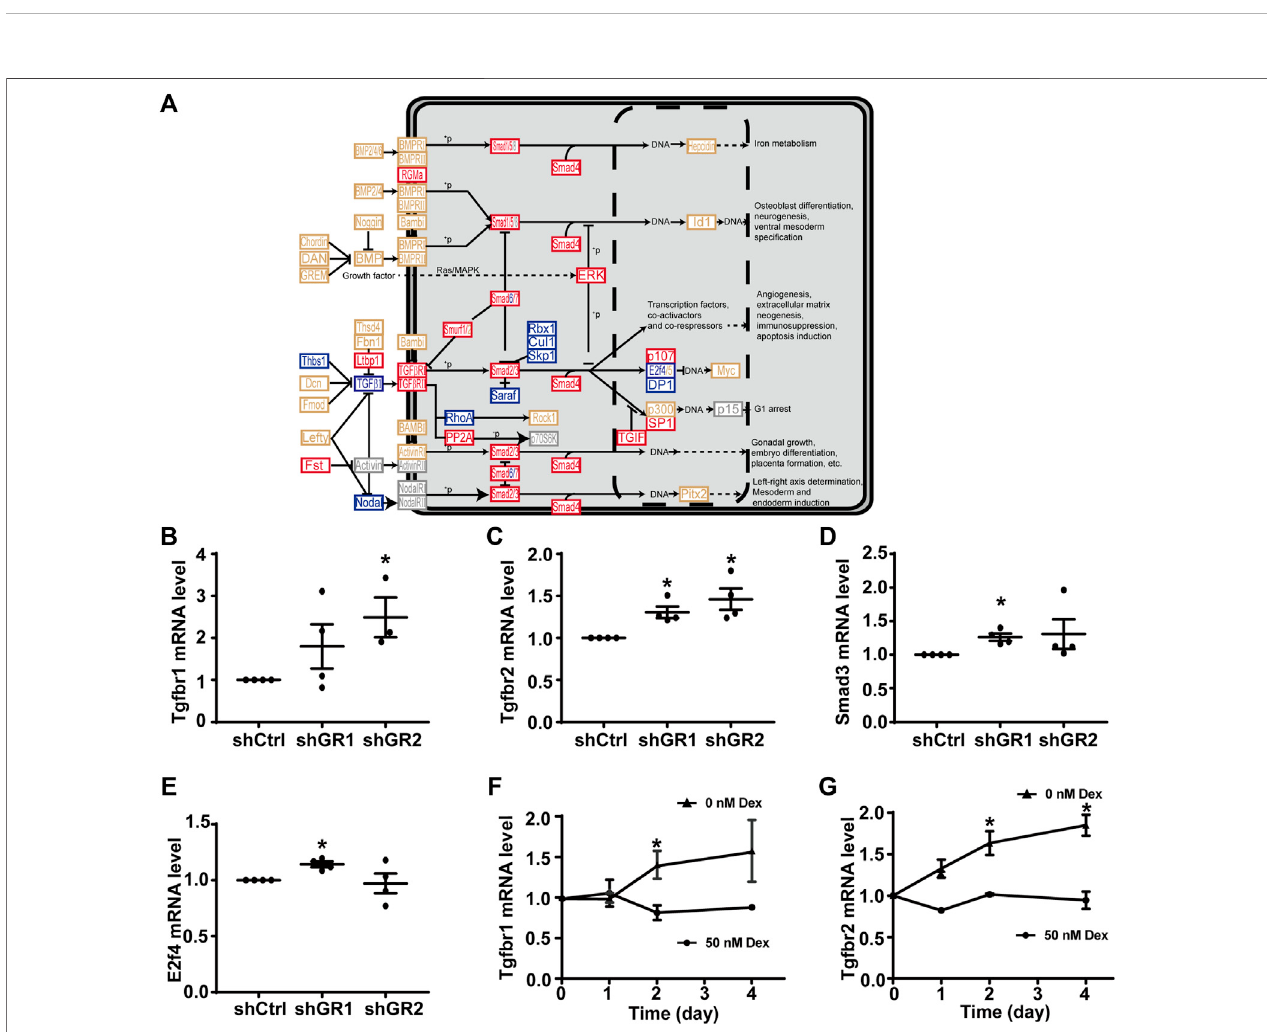
FIGURE4| GlucocorticoidreceptorknockdownenhancedtheKEGG “ TGF β signalingpathway ” inthempkCCDcells. (A) KEGG “ TGF β signalingpathway. ” Genes are abbreviated and colored: blue, downregulated; gray: not in RNA-seq data; red, upregulated; yellow, no change in the glucocorticoid receptor knockdown cells. + P, phosphorylate; − P, dephosphorylate. (B – E) Quantitative RT-PCR measurementsof Tgfbr1, Tgfbr2, Smad3, and E2f4 mRNA levels in control (shCtrl) and glucocorticoid receptor knockdown (shGR1 and shGR2) cells under vehicle conditions. Values are mean ± S. E. summarized from three or four independent experiments. Asterisks indicate statistical signi fi cance ( p < 0.05, t -test). (F,G) Quantitative RT-PCR measurements of Tgfbr1 and Tgfbr2 mRNA levels in polarized mpkCCD cells exposed to 0 vs. 50 nM dexamethasone